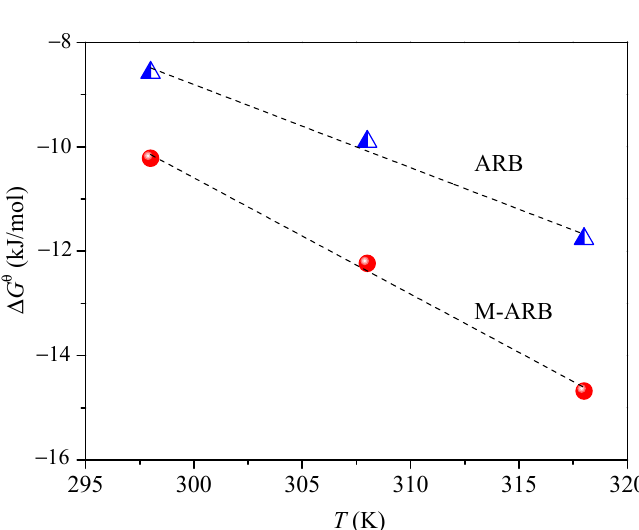
Figure 10. Adsorption thermodynamic fitting of MB onto ARB and M-ARB.